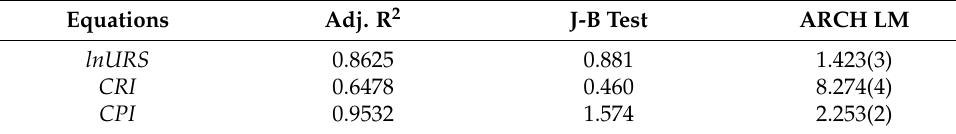
Table 7. Test results of J-B test and ARCH